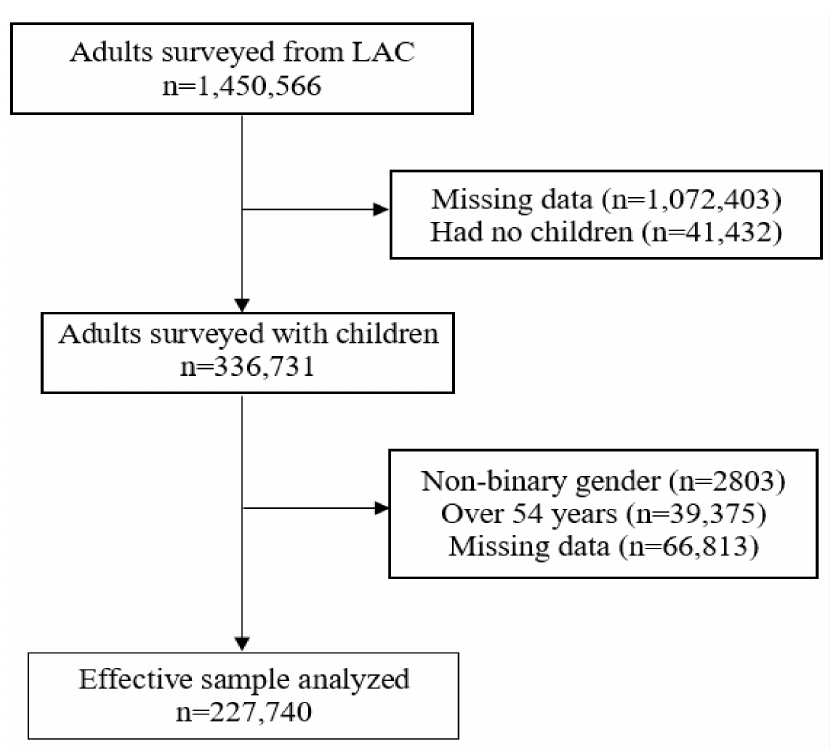
Figure 1. Flowchart of the selection of the study